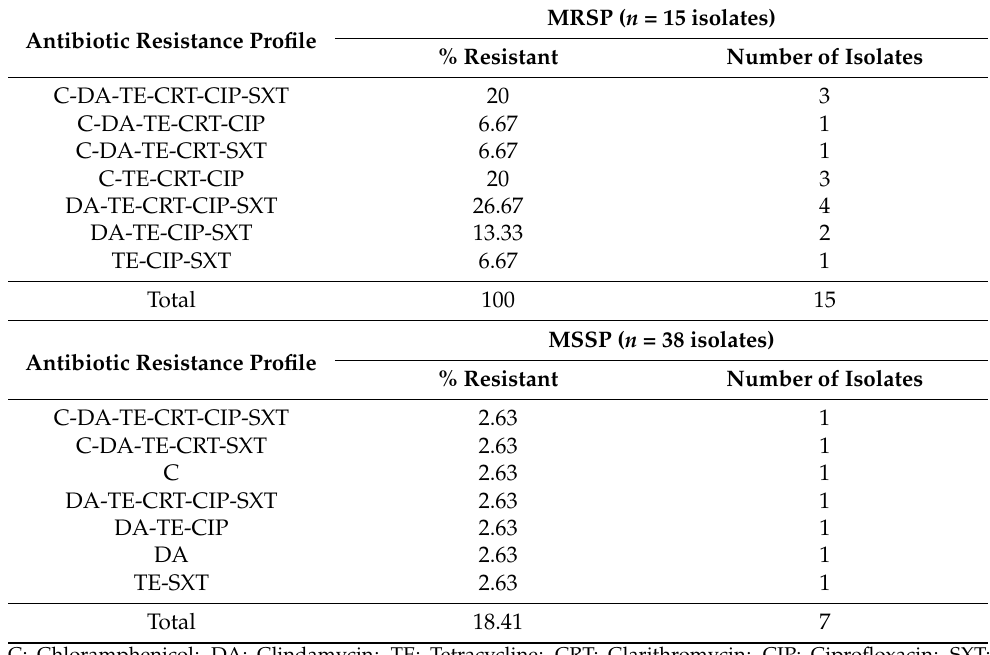
Table 2. Antibiotic resistance profile of methicillin-resistant and methicillin-susceptible S. pseudinter- medius isolates. MRSP ( n = 15 isolates) Antibiotic Resistance Profile % Resistant Number of Isolates C-DA-TE-CRT-CIP-SXT 20 3 C-DA-TE-CRT-CIP 6.67 1 C-DA-TE-CRT-SXT 6.67